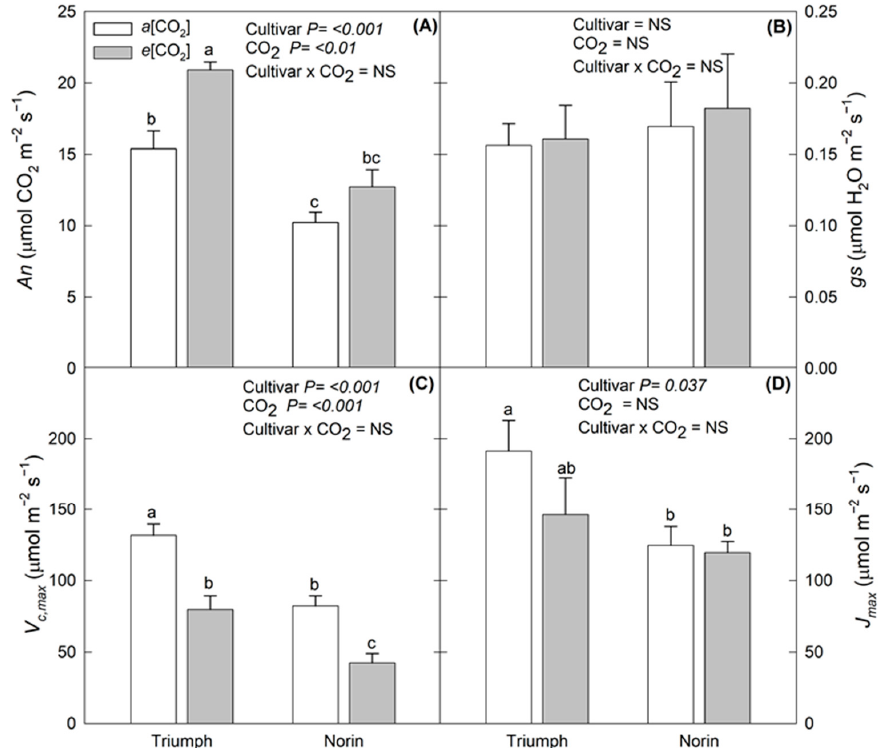
Figure 2. Physiological responses to e [CO 2 ] in both cultivars evaluated (Triumph and Norin). ( A ) An ; ( B ) gs ; ( C ) V c , max ; and ( D ) J max . Each bar indicates standard error of means ( n = 3) and cultivar, CO 2 and cultivar x CO 2 represents the ANOVA results of cultivar, [CO 2 ] and the interaction between them. Different letters indicate significant differences among treatments and cultivar.